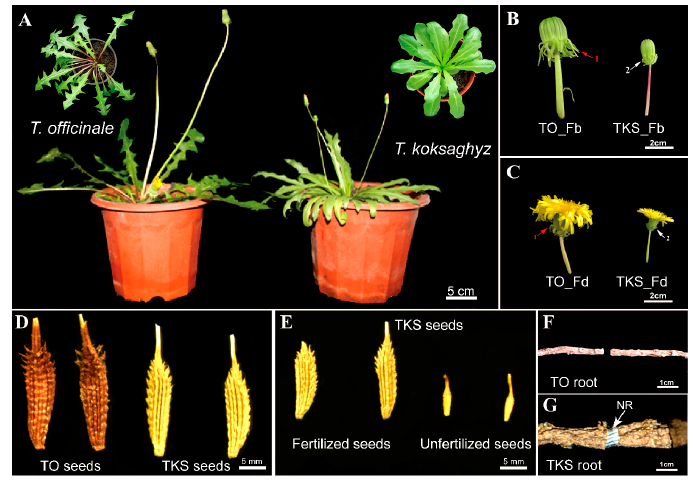
Figure 1. Morphological analysis of Taraxacum officinale (TO) and T. koksaghyz (TKS). Mature TKS ( right ) and TO ( left ) grown on semi-solid nutrient are presented ( A ). The flower buds ( B ), flowers ( C ), mature seeds ( D ), unfertilized seeds ( E ), mature roots ( F ), and root breaks ( G ) are highlighted to demonstrate the differences between the TKS and TO species.